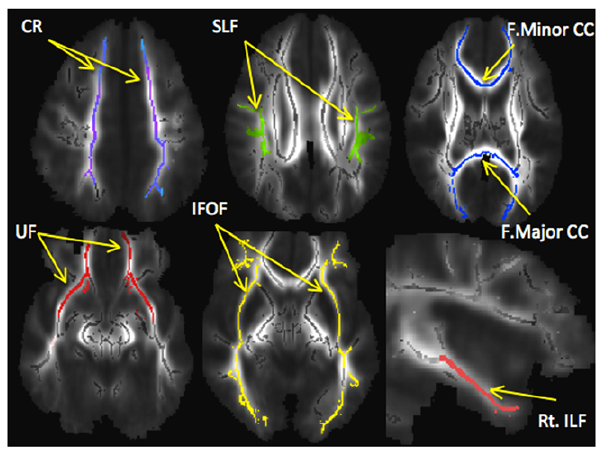
Figure 3. Skeletonized tract-specific regions of interest. Abbreviations: CR: superior corona radiata; SLF: superior longitudinal fasciculus; F.Minor CC: forceps minor corpus collosum; F.Major CC: forceps major corpus collosum; UF: uncinate fasciculus; IFOF: inferior fronto-occipital fasciculus; Rt. ILF: right inferior longitudinal fasciculus.